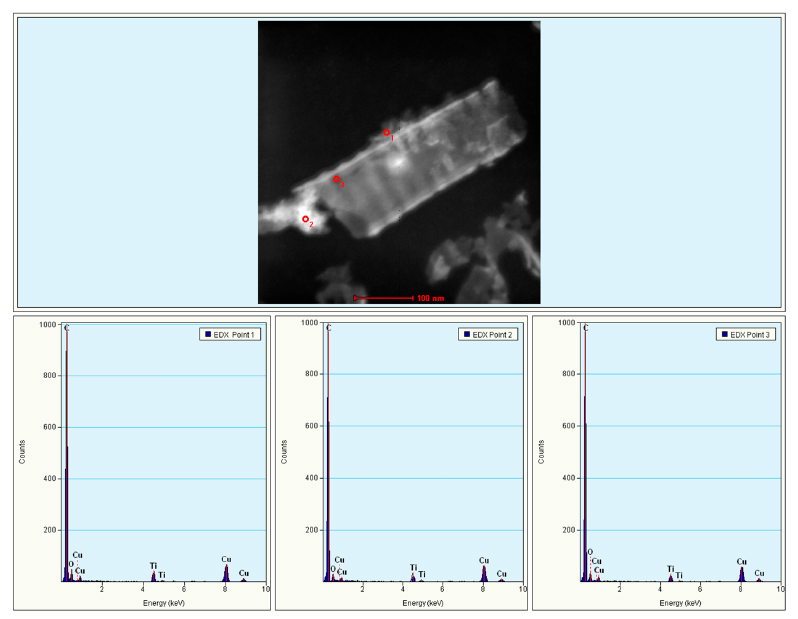
Figure 9. Energy dispersive x ‐ ray spectroscopy (EDS) of CuTiO 2 NTs labelled Cu ‐ 01.